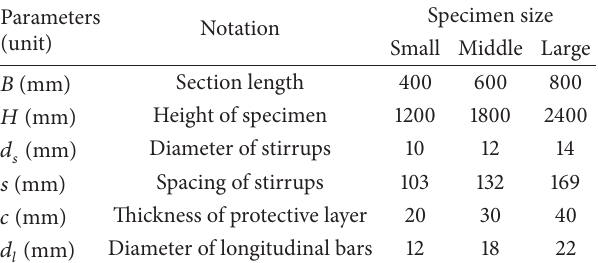
Figure 12: Final failure mode of specimens. Table 1: Design parameters of the specimens.